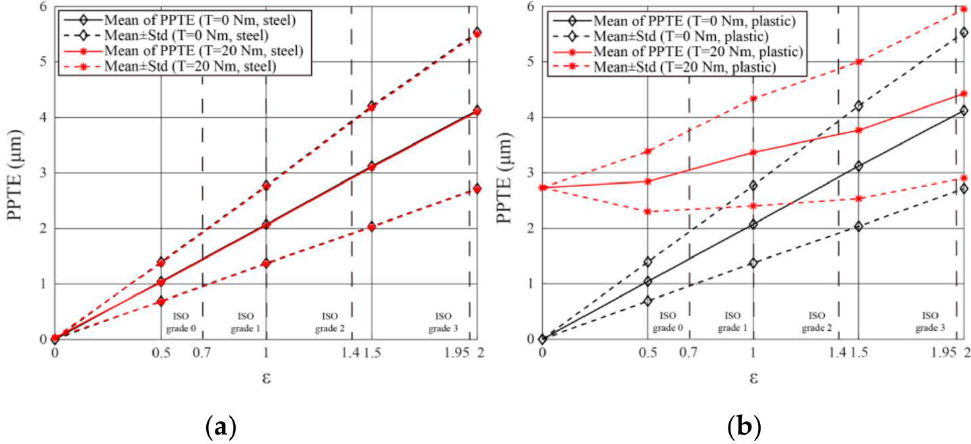
Figure 12. Peak-to-peak transmission error of ( a ) steel and ( b ) plastic gear with regard to change in (cid:101) . There is no thermal deformation or pitch error ( η = 0, e p = 0 )